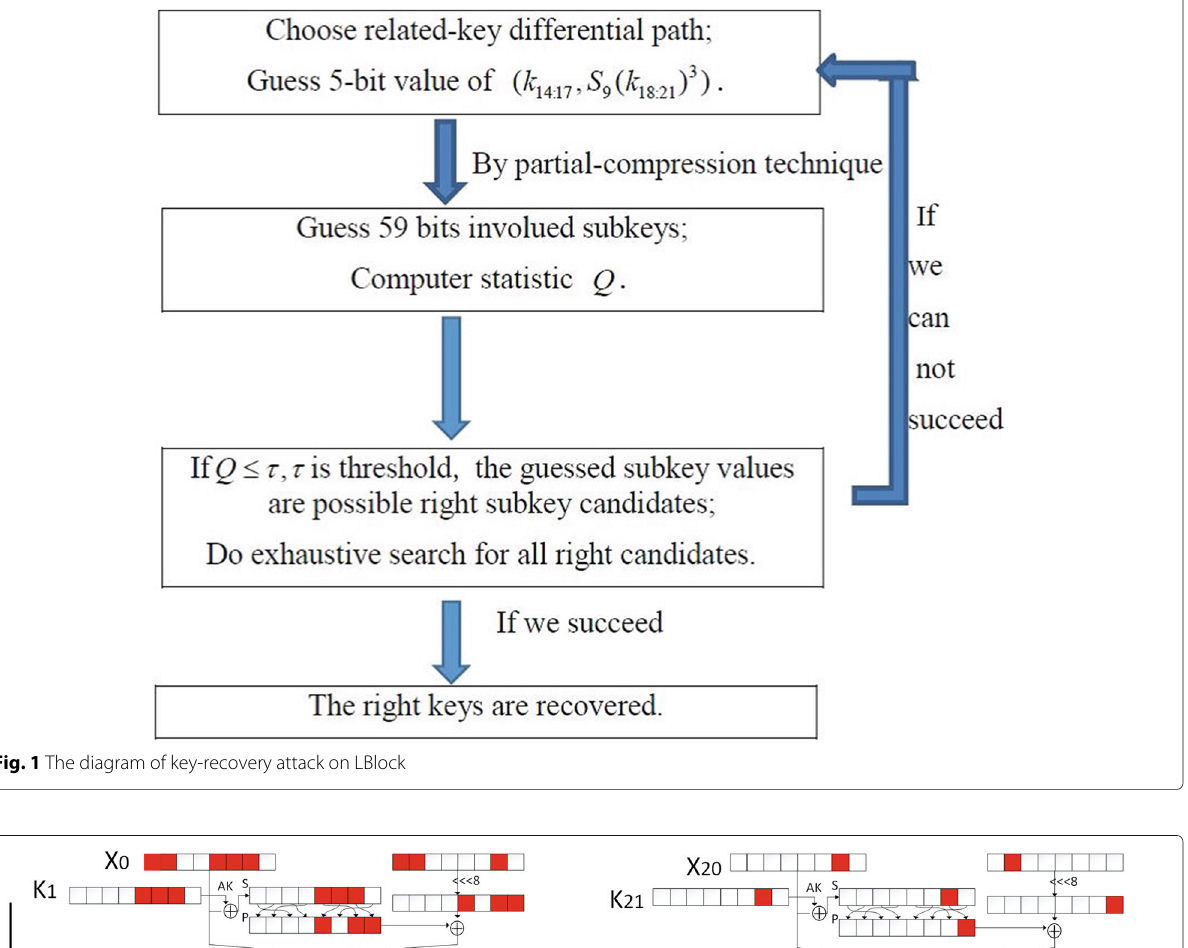
Fig. 1 The diagram of key-recovery attack on LBlock